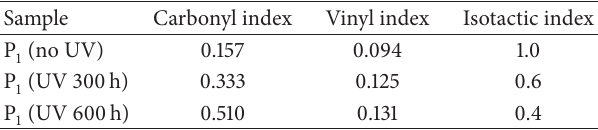
Figure 3: FT-IR spectra recorded for PP (blue) (a); P 3 -no UV (green) (b); P 3 -UV 300 h (red) (c); and P 3 -UV 600h (pink) (d). Table 1: Carbonyl, vinyl and isotactic indexes of unweathered and weathered PP-hemp shives